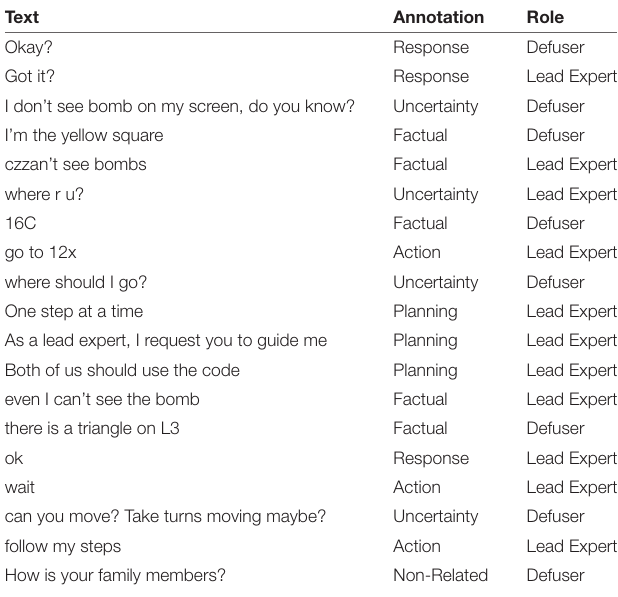
TABLE 4 | Example of an annotated chat sequence between a Lead Expert and a